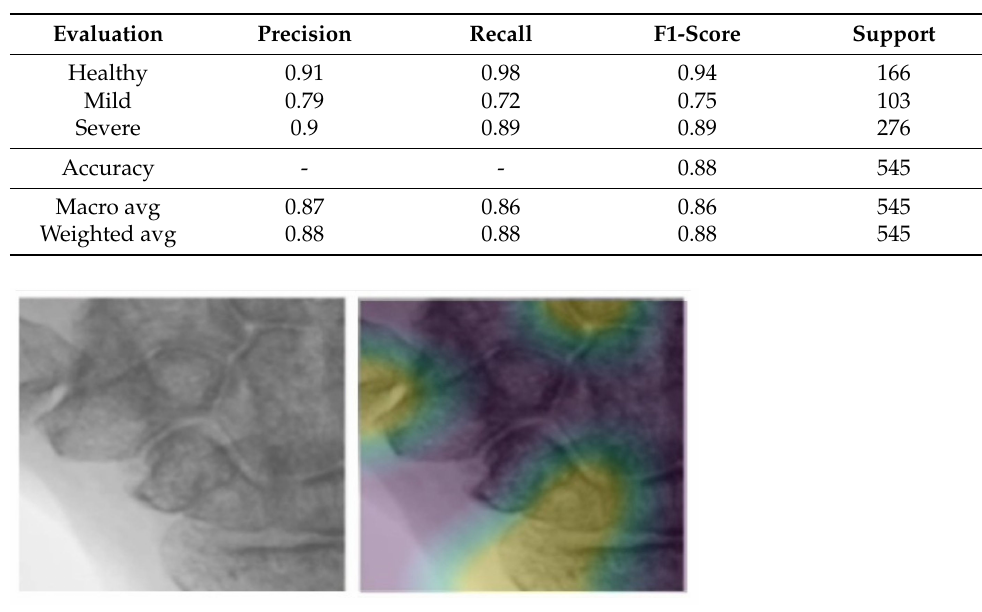
Figure 6. JSN model detection results; the left side of the image shows a hand with mild RA, while the right side of the image shows a hand with severe RA. Table 6. Results of classification model EfficientNet-B1 (192 × 192).